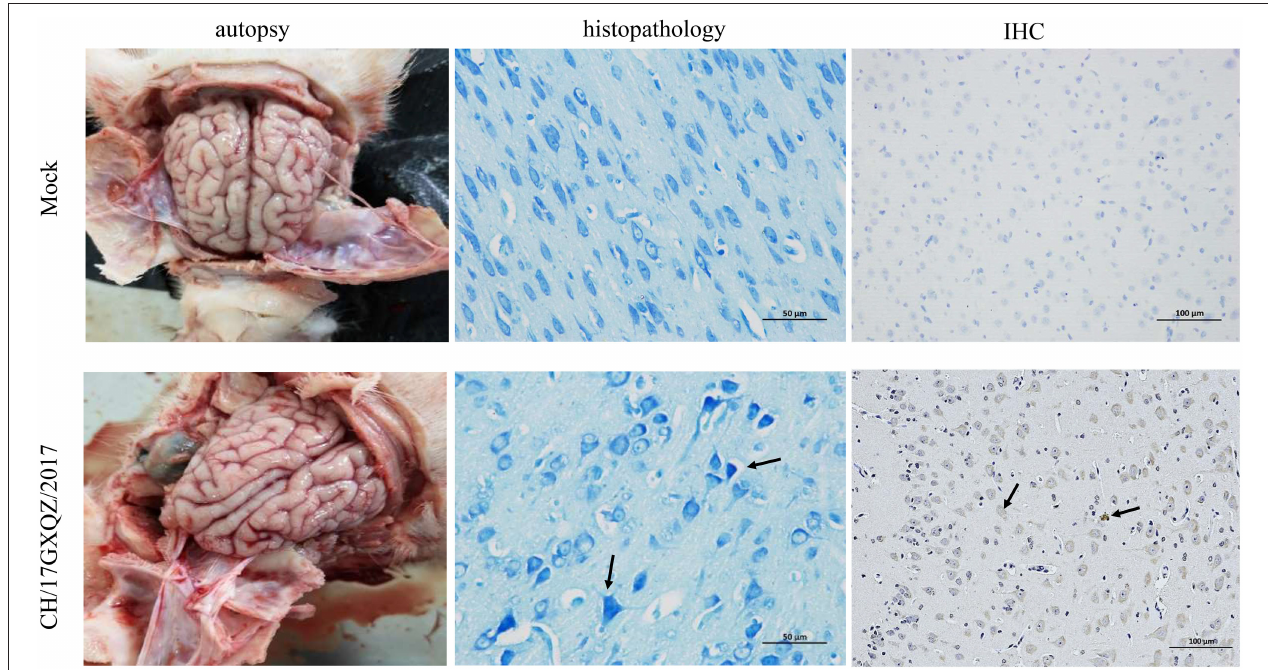
FIGURE 8 | Macroscopic, histologic lesions and immunohistochemistry of the cerebrum as caused by EV-G. Macroscopic observations of the brain of one representative piglet from the mock and the inoculated groups. The microscopic lesions observed in the cerebrum of piglets at 400 × magnification with Nissl staining of a section in one representative piglet from the mock and infected groups, and the black arrows in micrograph indicate Nissl bodies vacuolization, fusion and uneven dyeing. Immunohistochemical staining of cerebrum sections from the mock and EV-G-infected groups. EV-G antigen was detected (marked with black arrows) in the brain of EV-G-inoculated pigs. The neuronal cells of EV-G-inoculated piglets were stained brown and observed at 200 ×